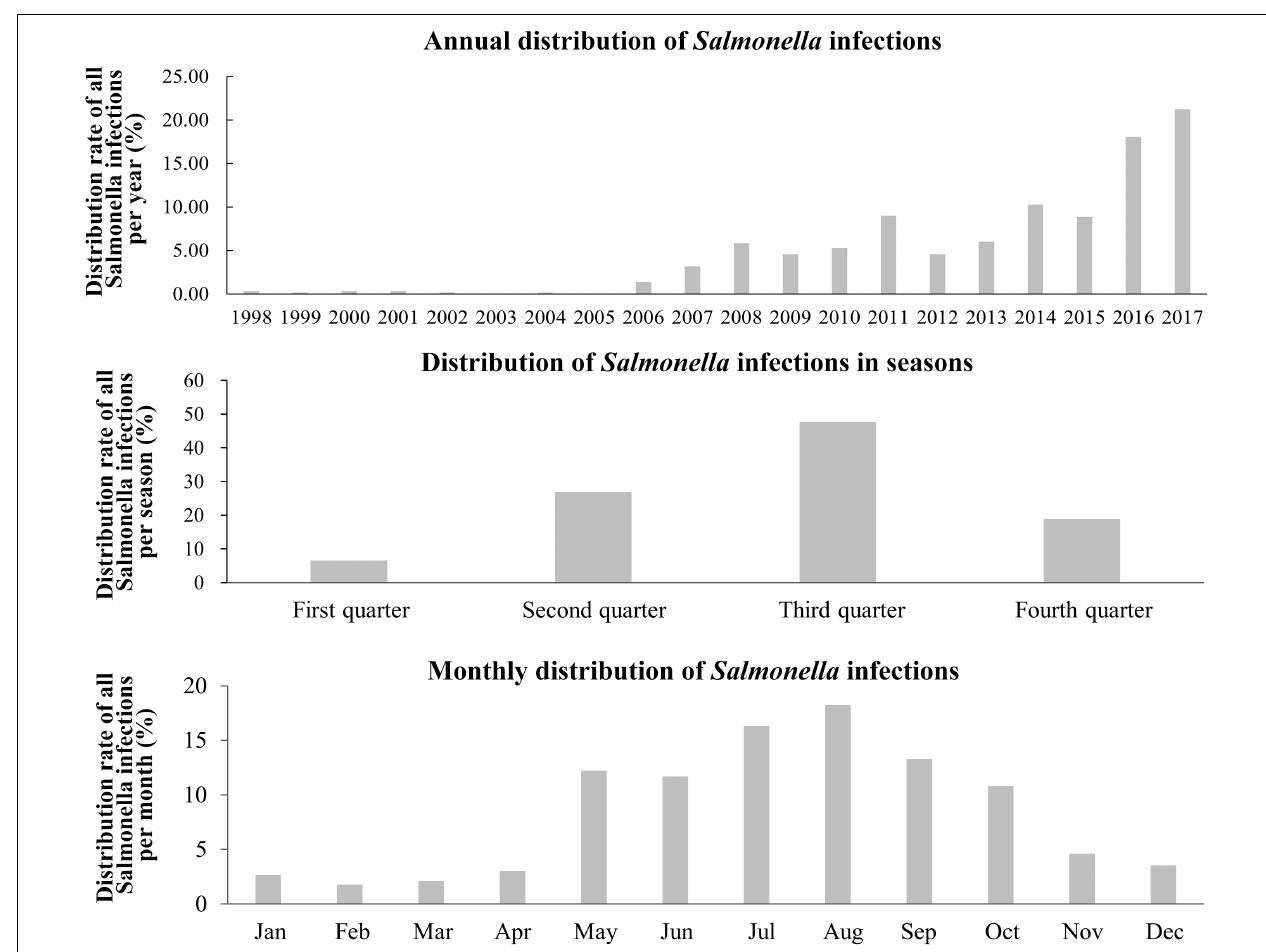
FIGURE 2 | Yearly, seasonally and monthly distribution of Salmonella infections in the Southwest of Shanghai from 1998 to 2017.